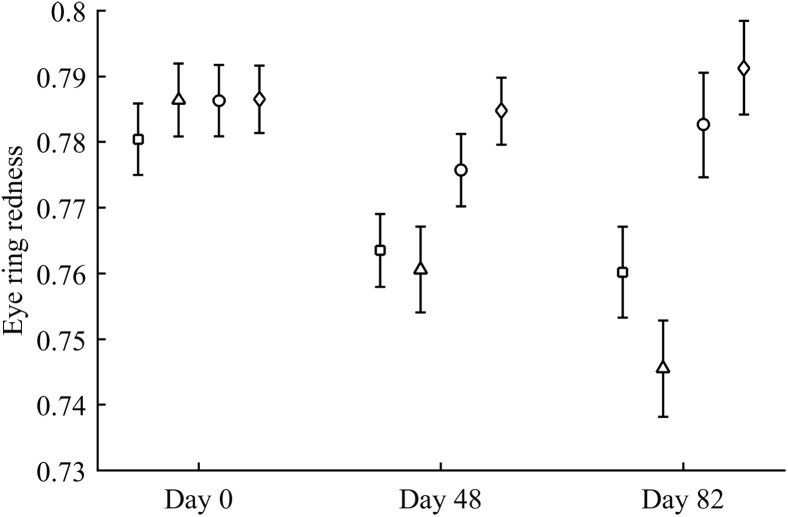
Changes in eye ring coloration during the experiment depending on the carotenoid treatment.Least square means ± SE were obtained from the models (see Methods). Squares: Control; Triangles: Astaxanthin; Circles: LutZea; Diamonds: ZeaLut.